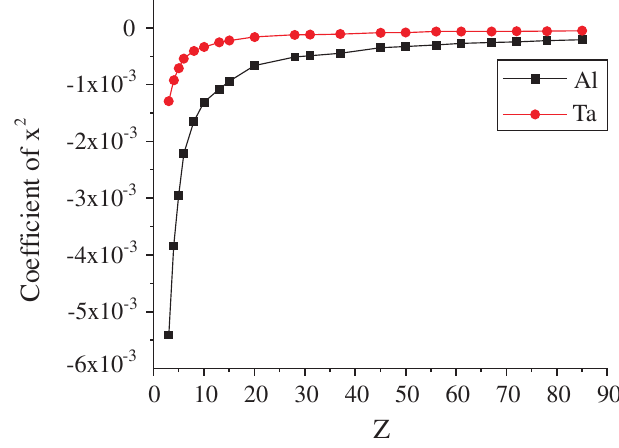
FIG. 10. (Color) Scaling of the wedge curvature for the 200 MeV = u case as a function of Z for two different wedge materials. The wedge thicknesses are 30% of the range in each case.